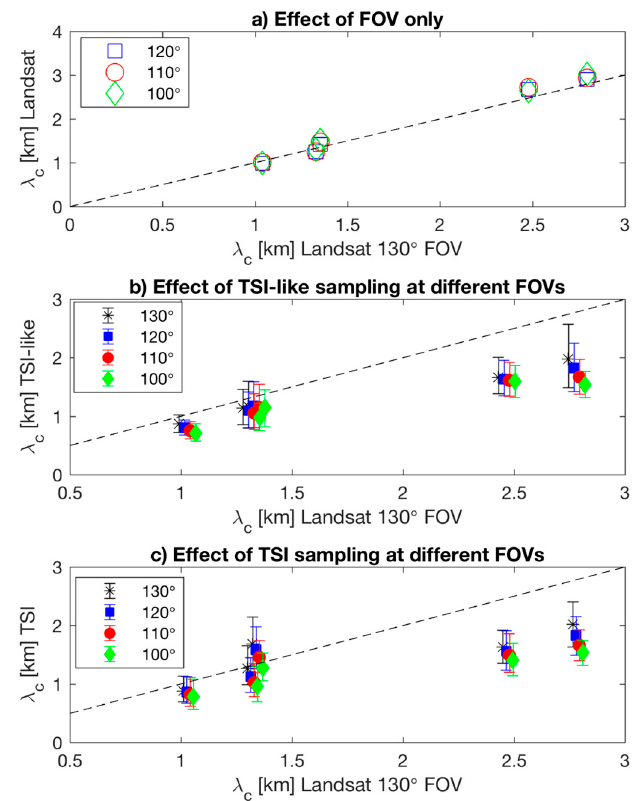
Figure A5. ( a ) Effect of maximum field of view (FOV) on characteristic cloud size ( λ c ) observed from the Landsat subarea. All clouds touching the FOV are included as whole. Dashed line is 1:1. ( b ) Mean and 95% confidence interval of λ c from 1000 simulated cloud fields drawn from simulated TSI-like cumulative distribution functions (see Figure A4). The TSI-like data drawn from four different FOVs are compared to 130° FOV Landsat data with a slight horizontal offset for visualization. ( c ) Same as Figure A5b, except using the real TSI data.